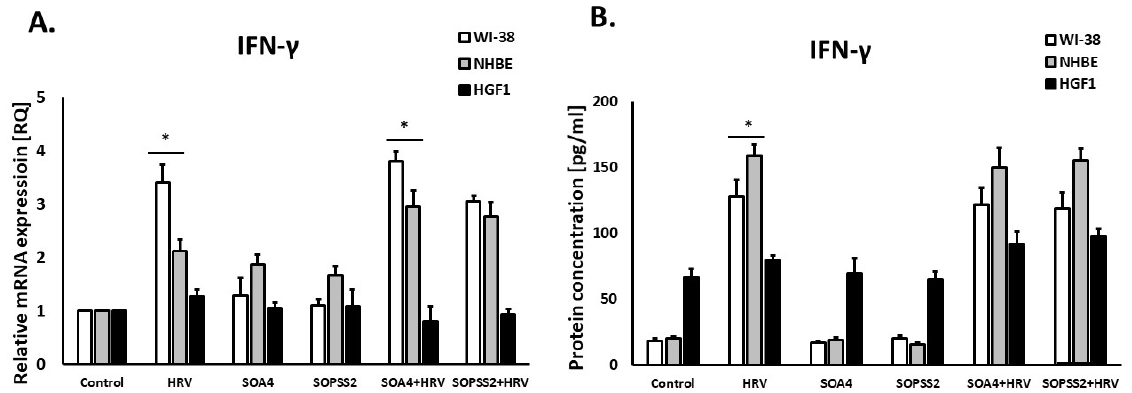
Figure 4. The e ff ect of the extracts from transformed (SOA4) and transgenic (SOPSS2) Senna obtusifolia hairy roots and viral infection (HRV-16) on the expression of IL-1 α on mRNA ( A ) and protein ( B ) levels in human cells. Data presented as mean ± SEM, * p < 0.05.